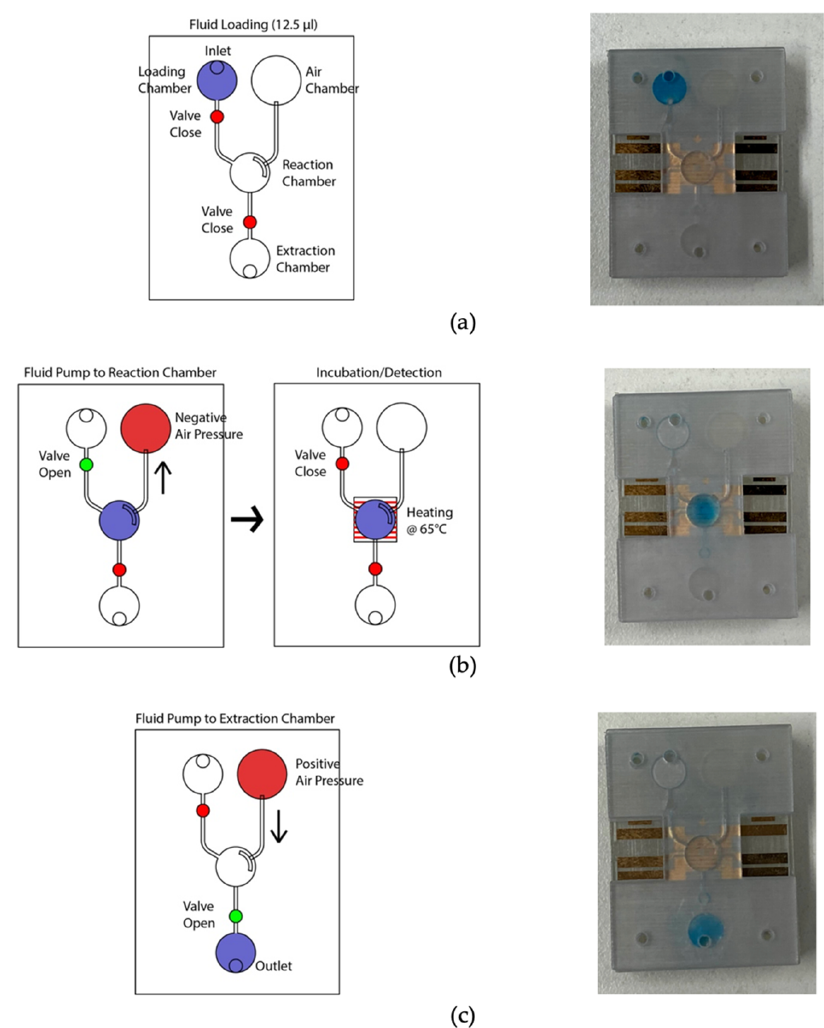
Figure 5. Photograph of the LAMP-chip in operation in line with the corresponding schematics. ( a ) Sample loading state, ( b ) sample transfer from loading chamber to amplification chamber, followed by the sample heating state, and ( c ) sample extraction state.